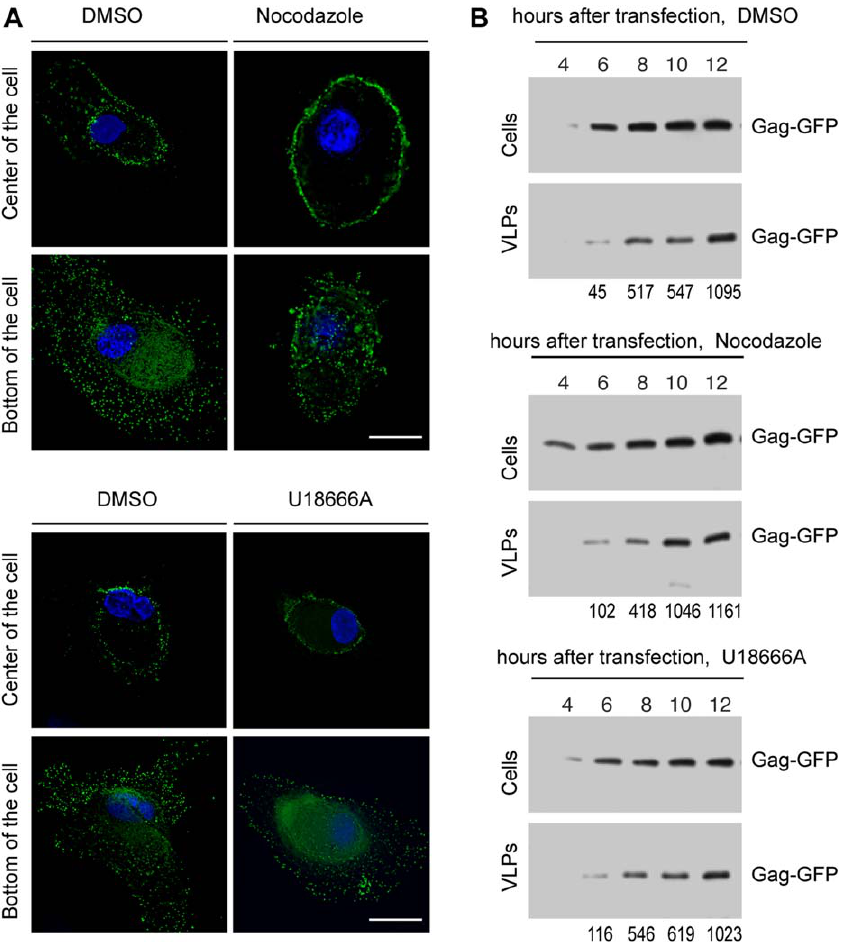
Figure 7. HIV-1 Assembly Does Not Required Microtubules or Endosome Motility in Primary Human Macrophages (A) Macrophages expressing Gag-GFP were treated with nocodazole or U18666A for the entire duration of Gag-GFP synthesis. Cells were fixed at 12-h post-transfection and stained with Hoechst 33258 (blue). Scale bars indicate 10 l m. (B) Western blot analysis of macrophages expressing Gag-GFP in the presence of DMSO, nocodazole, or U18666A. Samples were collected every 2 h, from 4- to 12-h post-transfection. Cell and virion lysates were probed with anti–HIV-1 CA antibodies. Numerical values below the blots indicate VLP signal intensities, derived by densitometry. DOI: 10.1371/journal.pbio.0040435.g007